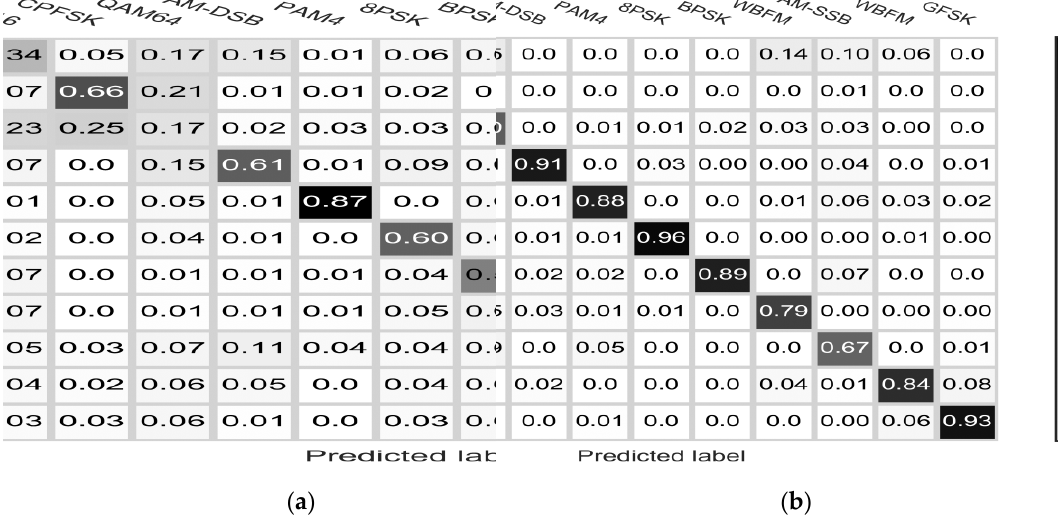
Figure 7. Confusion matrices for the modulation recognition data in SNR: ( a ) 0 dB; ( b ) 5 dB.